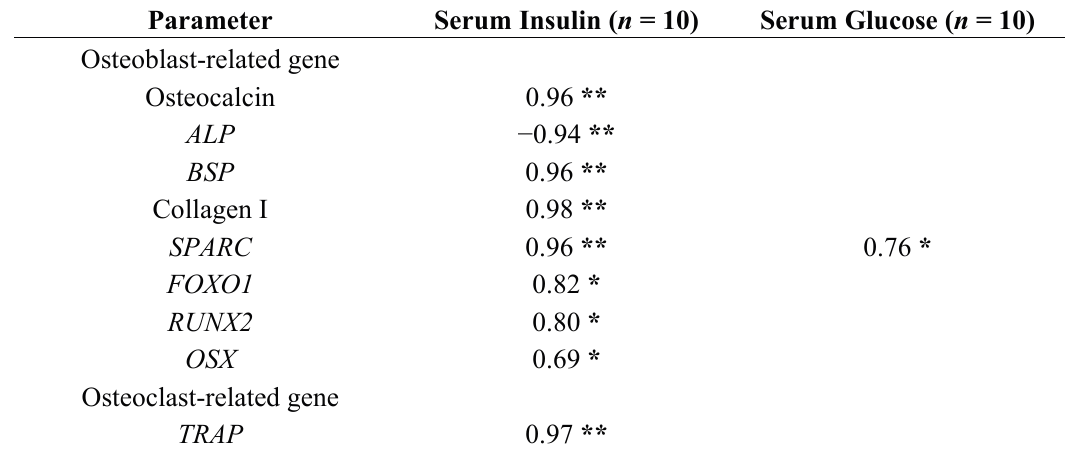
Table 2. Pearson’s correlation coefficients between serum insulin, glucose levels vs. bone turnover markers at 26